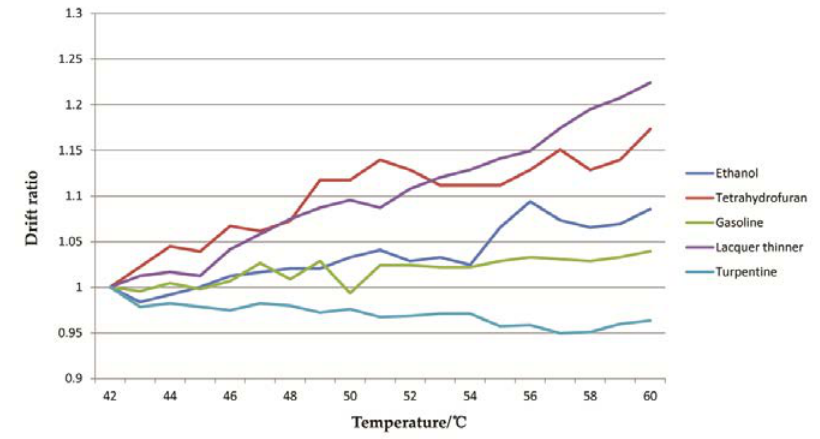
Figure 4. Temperature drift curves of sensor 4.